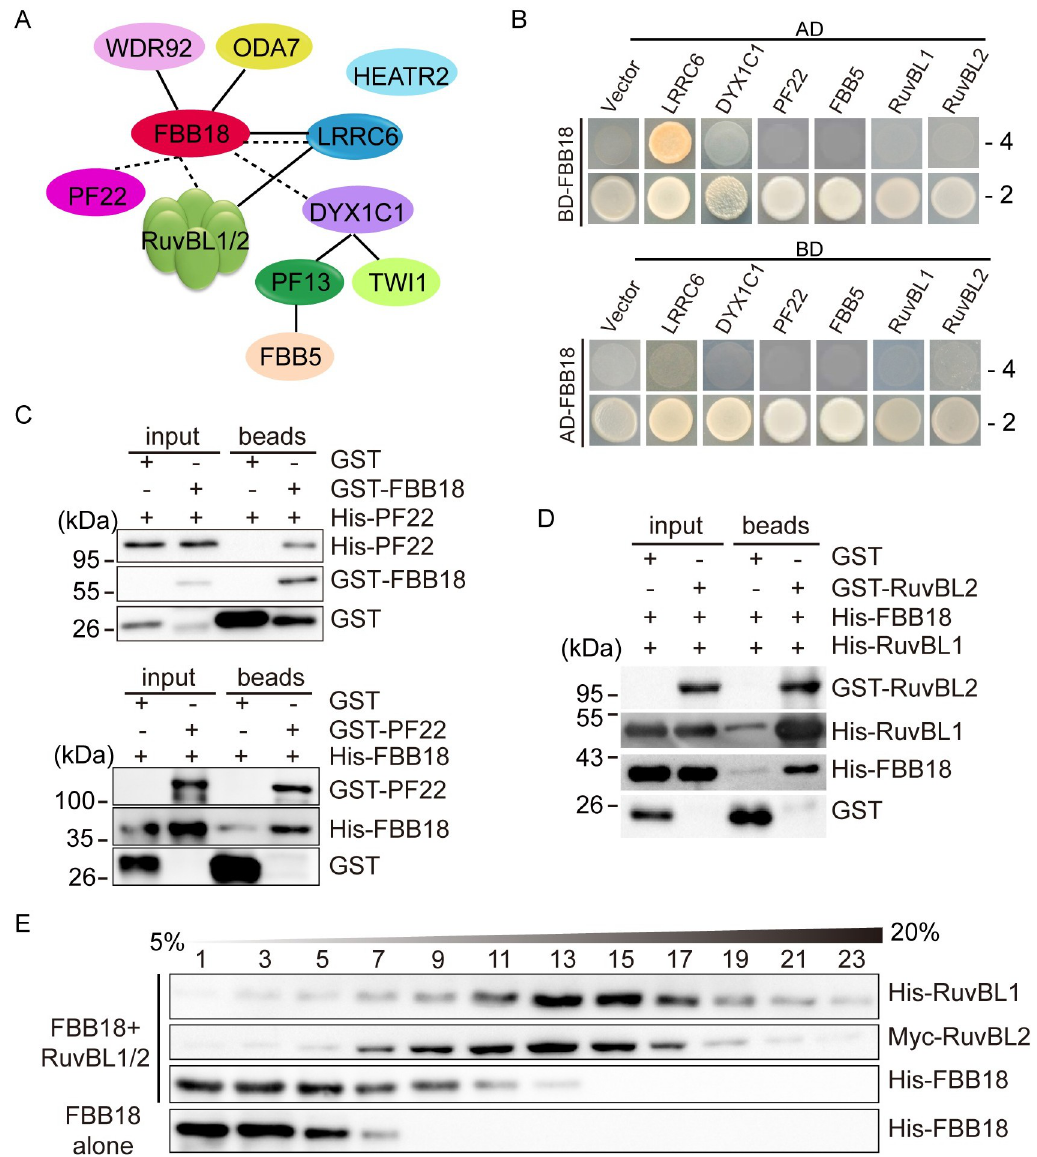
Fig 4. An interacting network(s) of FBB18 with other DNAAFs. (A) A model of molecular interaction map of FBB18. Dotted and solid lines represent interactions revealed by current and previous studies, respectively. (B) Y2H assays show direct interaction of FBB18 with LRRC6, DY1X1C1 but not the other proteins tested. Yeast cells that were transformed with each pair of constructs were grown under selection media lacking leucine, tryptophan, histidine, and adenine (-4) or leucine and tryptophan (-2). Empty AD or BD vectors were used as controls. (C) Reciprocal pull-down assays show interaction between FBB18 and DNAAF3/PF22. Bacterial expressed proteins were mixed as indicated and pulled down with glutathione beads followed by immunoblotting with GST and His antibodies, respectively. GST was used as a control. (D) Pull-down assays show interaction between FBB18 and RuvBL1/2. An assay similar to (C) was performed. GST and His antibodies were used for immunoblotting, respectively. (E) Sucrose gradient assay shows that FBB18 forms complexes with RuvBL1/2. Bacterial expressed proteins as indicated were subjected to sucrose gradient analysis followed by immunoblotting with His or Myc antibodies.